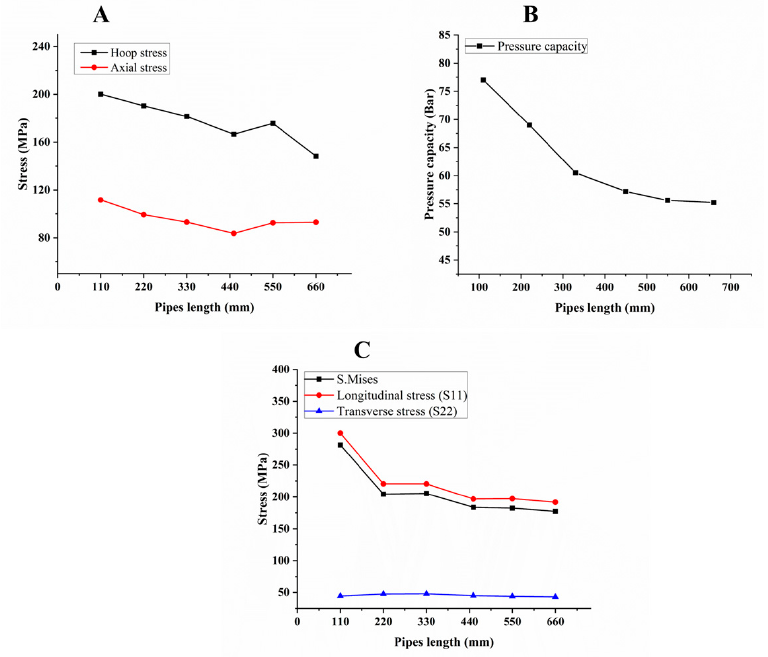
Figure 5. Hoop and axial stress ( A ), pressure capacity ( B ), and various stress ( C ) of [ ± 55] 3 composite pipes with different